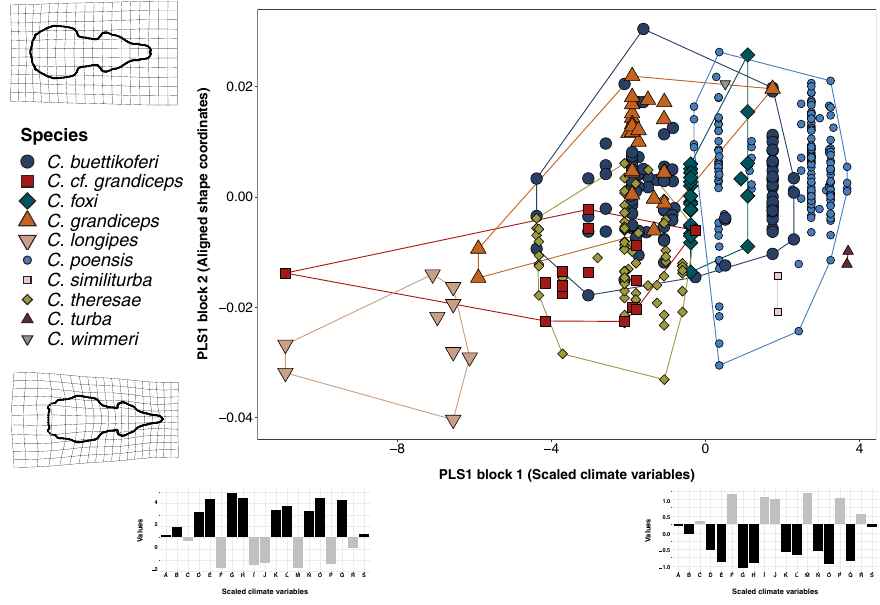
Figure 6. Two-block partial least square regression of shape and climate. Scatterplot of the first pair of Singular Warps of the Two Block Partial Least Squares analysis between scaled climatic variables (X axis) and symmetrical shape coordinates (Y axis). Deformation grids represent the shape for the minimum and maximum values of the first shape PLS axis plotted against the mean, with a magnification of 3. The climate variable plots represent the loadings of each original variable for the minimum and maximum values of the first climate PLS axis. The variables are as following, the bold ones being the main contributors: A: Annual mean temperature; B: Mean diurnal range; C: Isothermality; D: Temperature seasonality; E: Max temperature of warmest month; F: Min temperature of coldest month; G: Temperature annual range; H: Mean temperature of wettest quarter; I: Mean temperature of driest quarter; J: Mean temperature of warmest quarter; K: Mean temperature of coldest quarter; L: Annual precipitation; M: Precipitation of warmest month; N: Precipitation of driest month; O: Precipitation seasonality; P: Precipitation of wettest quarter; Q: Precipitation of driest quarter; R: Precipitation of warmest quarter; S: Precipitation of colder